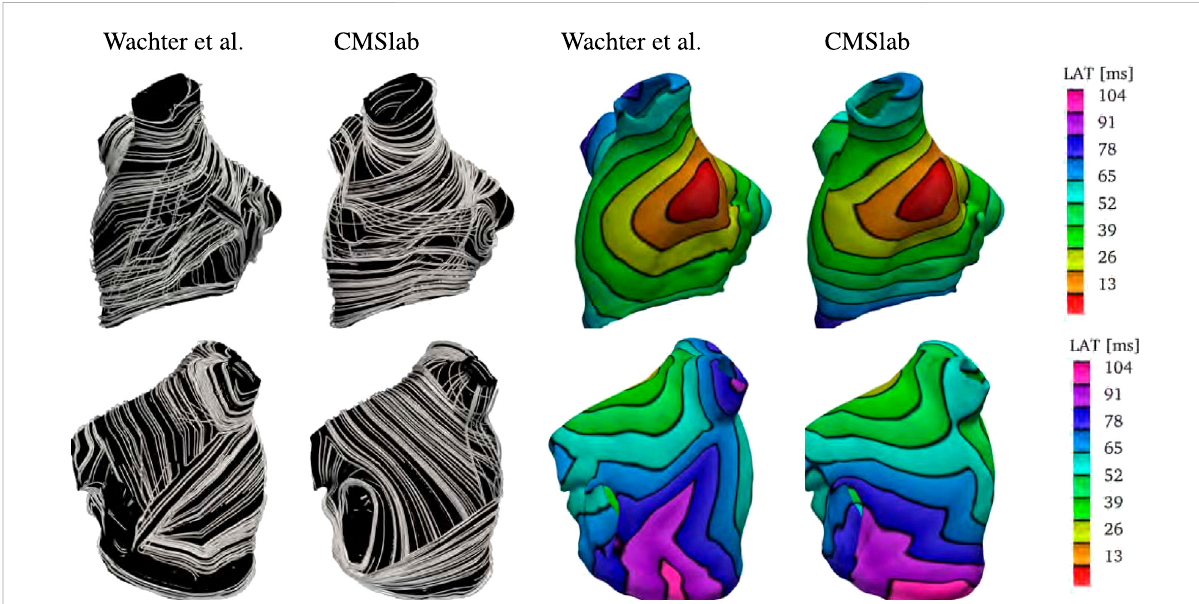
FIGURE 10 Comparisonoftheresultsobtainedusingtheproposed fi berconstructionalgorithmandpreviouslyproposedbyWachteretal.(2015).Usingthe geometryprovidedbyLoeweetal.(2016),wehavebuiltourapproximationtotheleftatrial fi berarchitecture.Noticethattheepicardial fi berstructure proposed by Wachter et al. (2015) is dominated by the septopulmonary bundle in the anterior wall. The Bachmann ’ s bundle is de fi ned in a narrower area than in the proposed algorithm. Therefore, the proposed algorithm yields an activation pattern with a pronounced horizontal component whencomparedtothemodelcreatedbyWachteretal.(2015).Incontrastwiththemodelproposed byWachteretal.(2015),theproposedalgorithm yields longitudinal fi bers in the inferior part of the epicardial septal region. This difference results in earlier activation of the left inferior PV in the former model than in the latter one. Besides that, in the model by Wachter et al. (2015), the myocardial strands cross the posterior wall in a higher position than the proposed model. This leads to a more oblique activation pattern in the posterior wall of the former model than in the latter